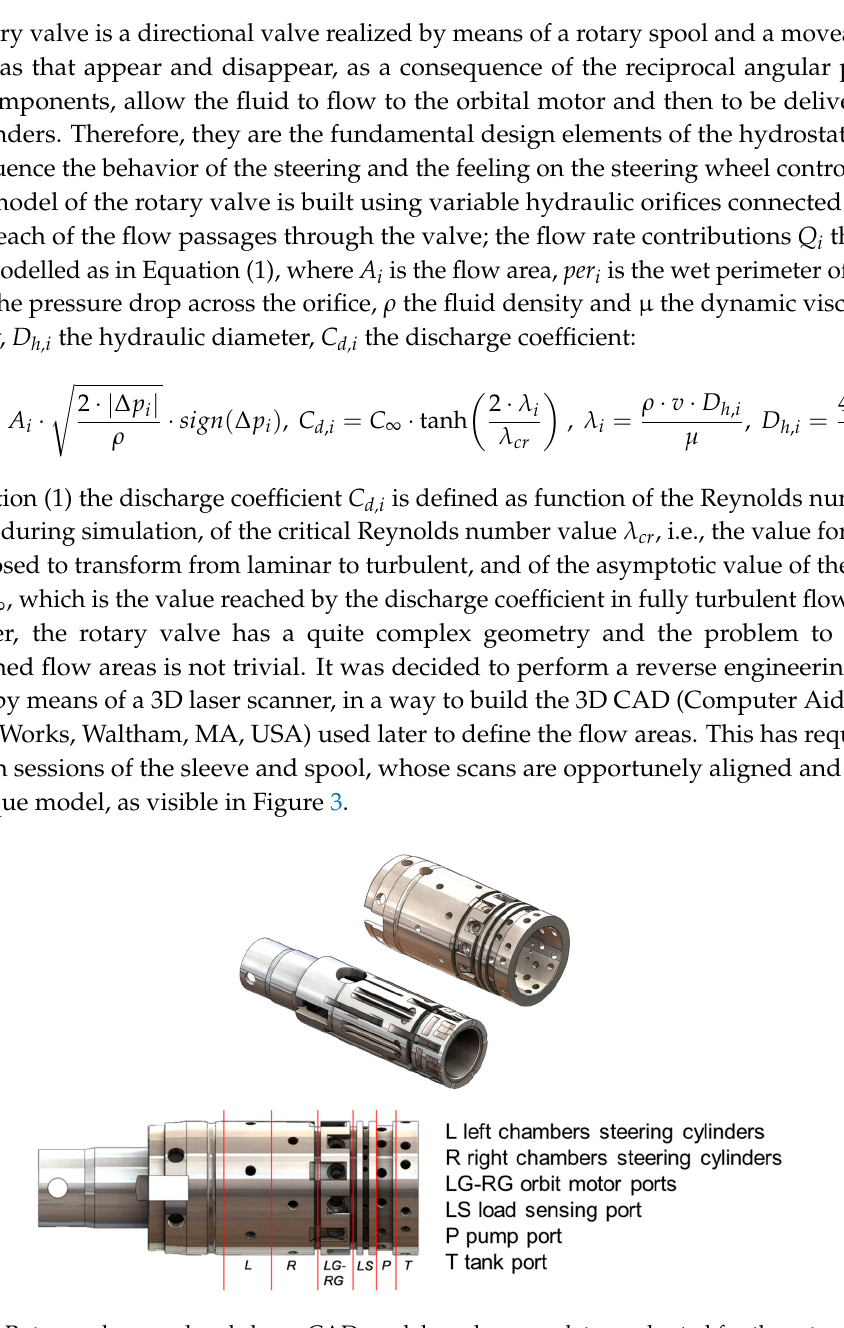
Figure 3. Rotary valve spool and sleeve CAD models and nomenclature adopted for the rotary valve ports and flow